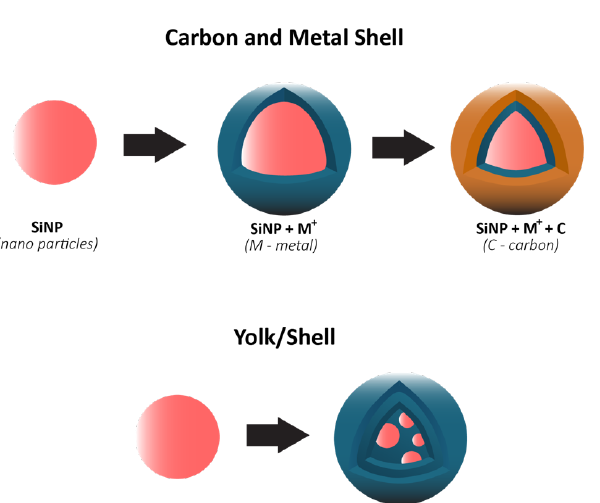
Figure 19. ( Top ) Carbon shell design, and ( Bottom ) Yolk/Shell design strategies for composite Si anodes. Adapted from